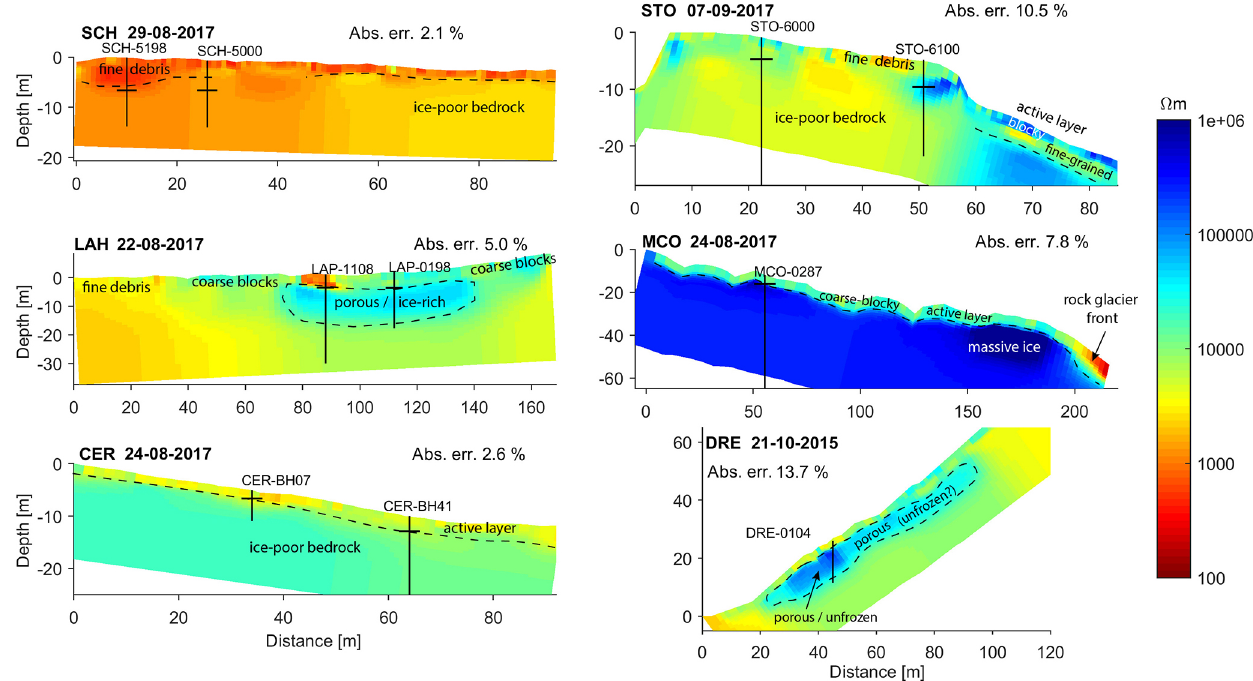
Figure 6. Representative end-of-summer tomograms for each site with interpretation of major characteristics. Boreholes along the resistivity profiles are represented in black, with horizontal lines indicating the thaw depth at the date of the ERT measurement, except for DRE, where the borehole is completely unfrozen at the time of ERT measurement. Note a second line for LAH at borehole LAP-1108 has been added to represent the permafrost base